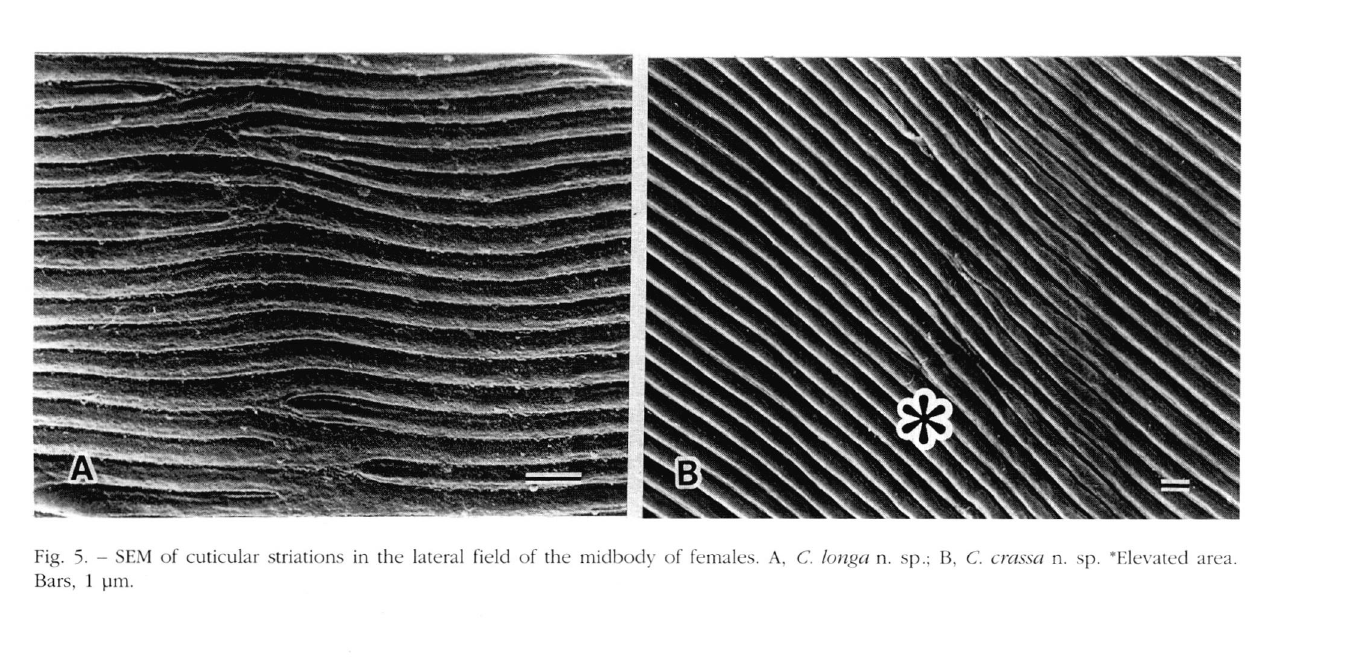
the species from Capreolus capreolus, C. rugosicauda